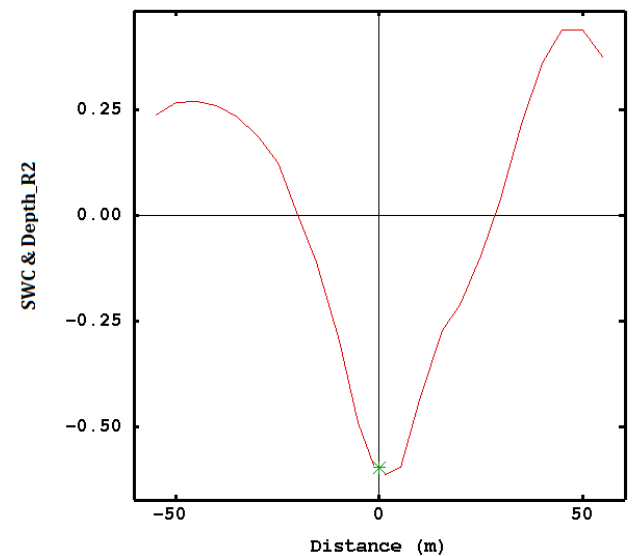
Figure 8. Cross correlogram between SWC and the depth of second reflection (Depth_R2). Correlation coefficients at lag 0 are significant at a 0.05 probability level.